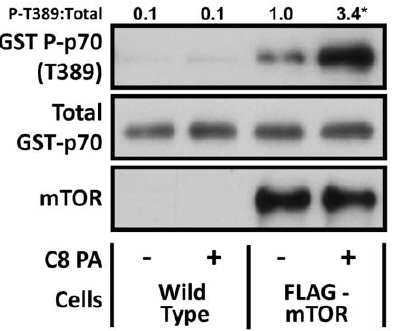
Figure 5. Phosphatidic acid directly promotes mTOR kinase activity in-vitro . Wild type C2C12 myoblasts and C2C12 myoblasts stably expressing FLAG-tagged mTOR (FLAG-mTOR) were serum starved overnight, collected, and then the cell lysates were subjected to immunoprecipitation against the FLAG epitope. The immunoprecipi- tates were incubated for 15 min with either 150 m M C8 PA vesicles (50% C8 PA + 50% PC) or 150 m M phosphatidylcholine (PC) vesicles (100% PC) as a control condition. mTOR kinase activity was then assayed with GST- p70 as a substrate. The resulting samples were subjected to western blot analysis, and the phospho:total ratios for GST-p70 were expressed relative to the values obtained in the PC treated FLAG-mTOR group. All values are presented as the mean and were obtained from at least three independent experiments (n=5 2 8 per group). *Significantly different from the cell type-matched control group, P #